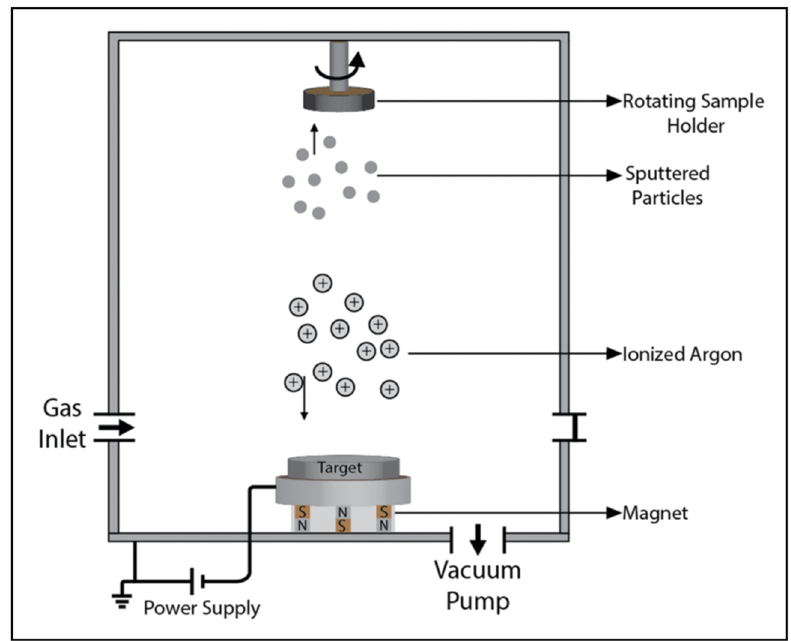
Figure 12: Schematic illustration of the MS process [ 104 ] . Copyright 2020, Royal Society of